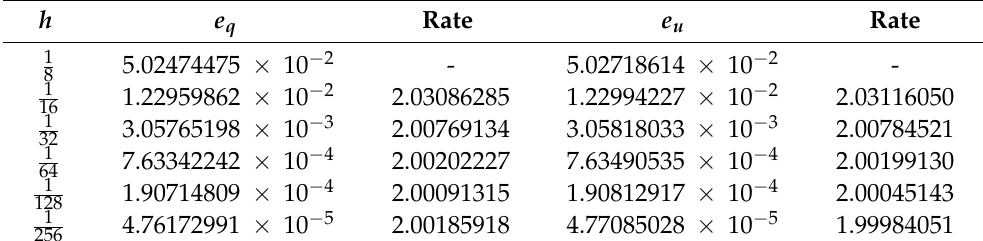
Table 2. Error e q and e u for the spatial convergence rates with α = 0.5.